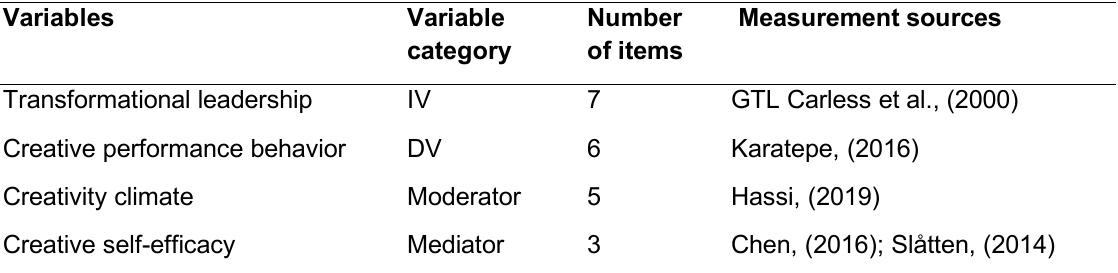
Table 1: Summary of variables and